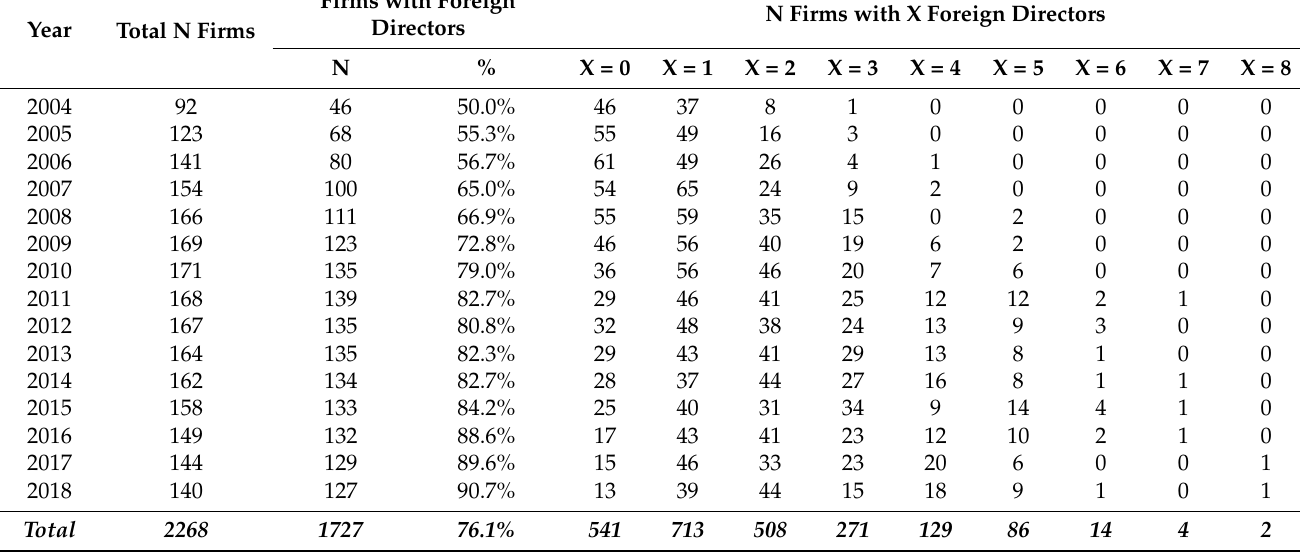
Table 1. Foreign directors on